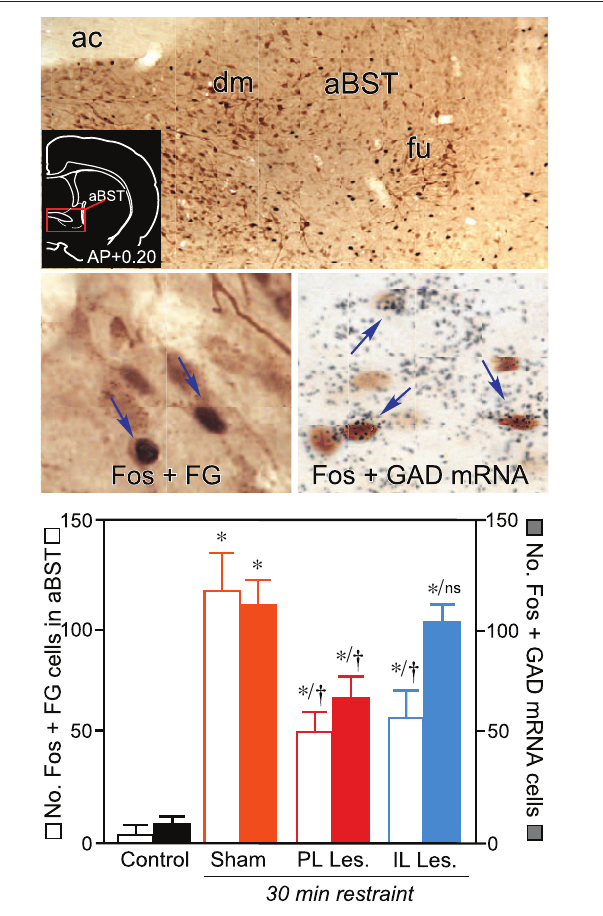
FIGURE 2 | Top: Brightfield photomicrograph showing stress-induced Fos immunoreactivity (black nuclei) and Fluoro-Gold (FG; brown cytoplasm) in anterior bed nuclei of the stria terminalis (aBST). Retrogradely-labeled cells are concentrated in fusiform (fu) and dorsomedial (dm) subnuclei of aBST following tracer injections centered in the PVH. Inset: Coronal section showing the approximate location of aBST corresponding to the region comprising the relevant subdivisions (red box). Middle left: Following restraint stress, cells doubly-labeled for Fos and Fluoro-Gold (arrows) are abundant in sham-lesioned animals. Middle right: Concurrent labeling for Fos (brown) with glutamic acid decarboxylase (GAD67) mRNA (black grains) showing comparable increases in doubly-labeled cells (arrows) in the sham-lesioned group following restraint stress. Bottom: Mean + SEM number of neurons co-labeled for Fos and Fluoro-Gold, and for Fos and GAD67 mRNA, in aBST of treatment groups. Whereas both PL and IL lesions reliably diminished stress-induced activation of PVH-projecting neurons in aBST, only PL lesions resulted in a decrease in the activation of GABAergic neurons in this subregion, implicating different relays for prefrontal modulation of the stress axis. ∗ Differs significantly from sham-lesioned control animals, p < 0 . 05. † Differs significantly from sham-lesioned stressed animals, p < 0 . 05. Portions of these data have been derived from Radley et al. (2009), and Radley and Sawchenko (2011). Data on IL lesion effects on stress-induced aBST activation are previously